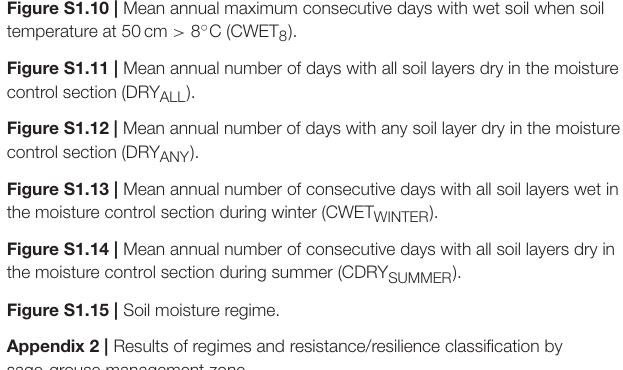
Figure S2.1 | Sage-grouse management zones. Zone 1: Great Plains; Zone 2: Wyoming Basins Zone 3: Southern Great Basin; Zone 4: Snake River Plain; Zone 5: Northern Great Basin; Zone 6: Columbia Basin; and Zone 7: Colorado Plateau. Figure S2.2 | Projected proportions of each soil temperature regime for each greater sage grouse management zone. Figure S2.3 | Projected proportions of each soil moisture regime for each greater sage grouse management zone. Figure S2.4 | Lookup table for assigning resistance and resilience categories based on soil temperature and moisture, synthesized from previous studies. Figure S2.5 | Layout for resistance within MZs. Figure S2.6 | Layout for resilience within MZs.